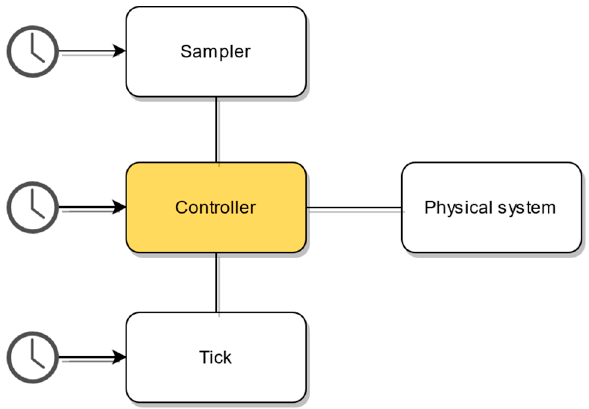
Figure 7. Structure of matrix converter in U PPAAL .